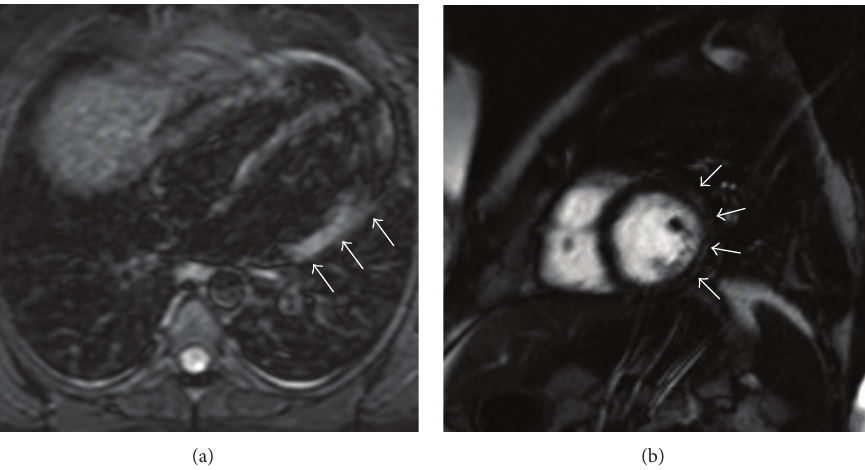
Figure 2: MRI finding of the patient. (a) Short TI inversion recovery (STIR) 4-chamber view showing hyperintense signal of the lateral inferior wall (arrows) suggesting focal edema. (b) Delayed enhancement of midmyocardial short axis showing hyperintense signal on the lateral inferior wall as well as delayed enhancement of the midepicardium and subepicardium